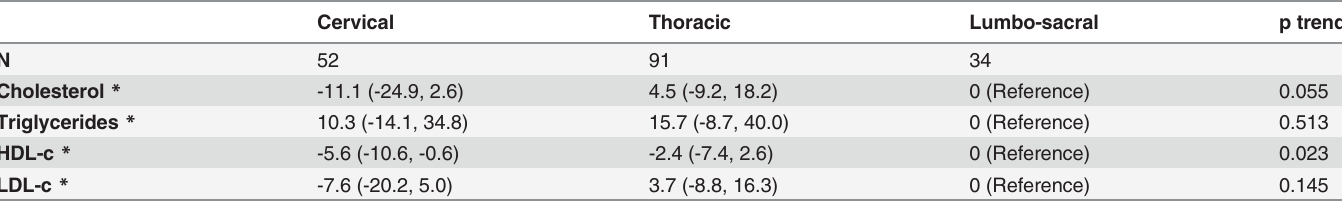
Table 3. Differences in serum lipids classi fi ed according to detailed neurological level of injury.